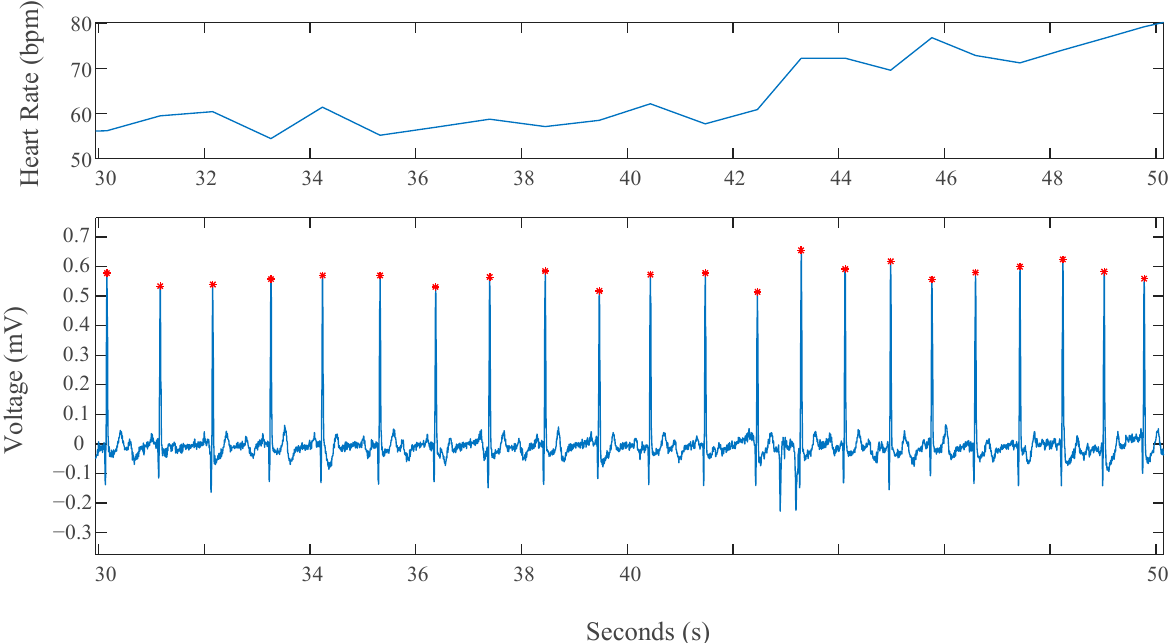
Figure 5. R-peak detection ( lower panel ) and results of the HR series calculated for ECG analysis ( upper panel ).